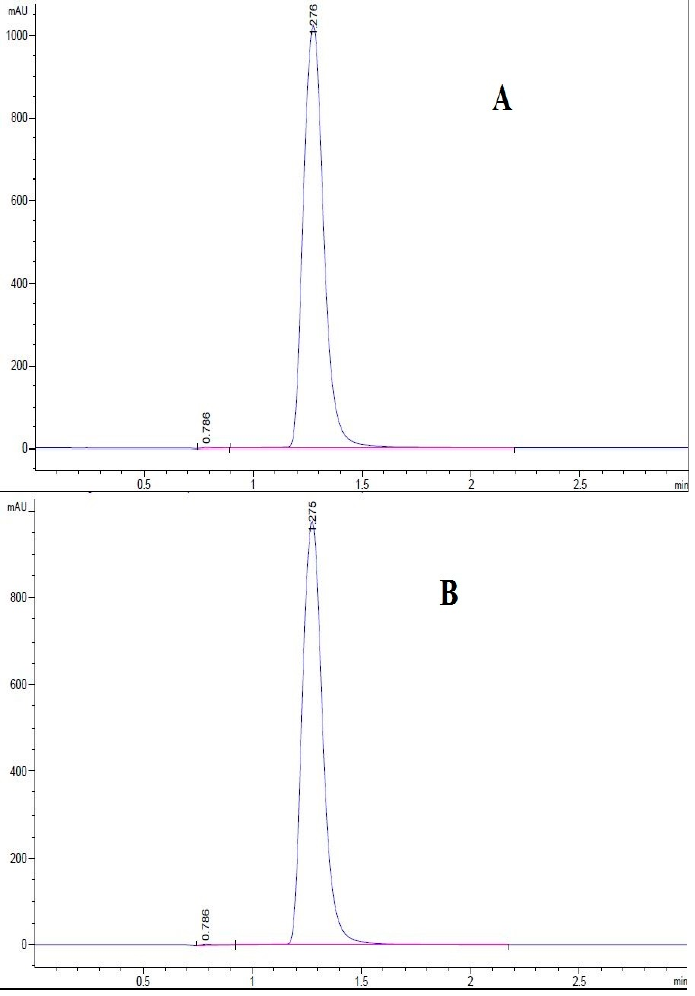
Figure 4. Determination of CCGA standard and extraction of CCGA from A. adenophora by UHPLC ( A ): Standard (0.2 mg/mL). ( B ): CCGA in A. adenophora .